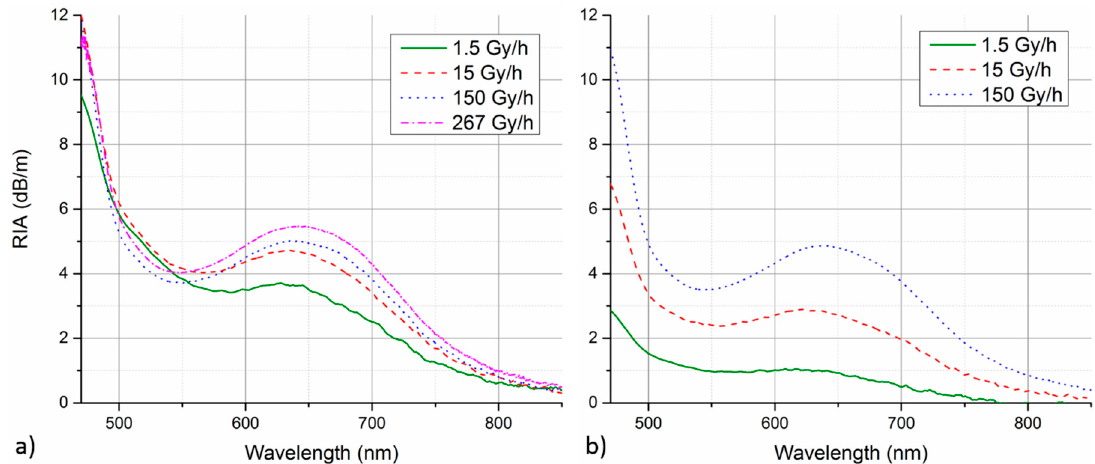
Figure 2. Spectral shape of GigaPOF-50SR ( a ) and Fontex ( b ) RIA measured for irradiation to 100 Gy at different dose rates.